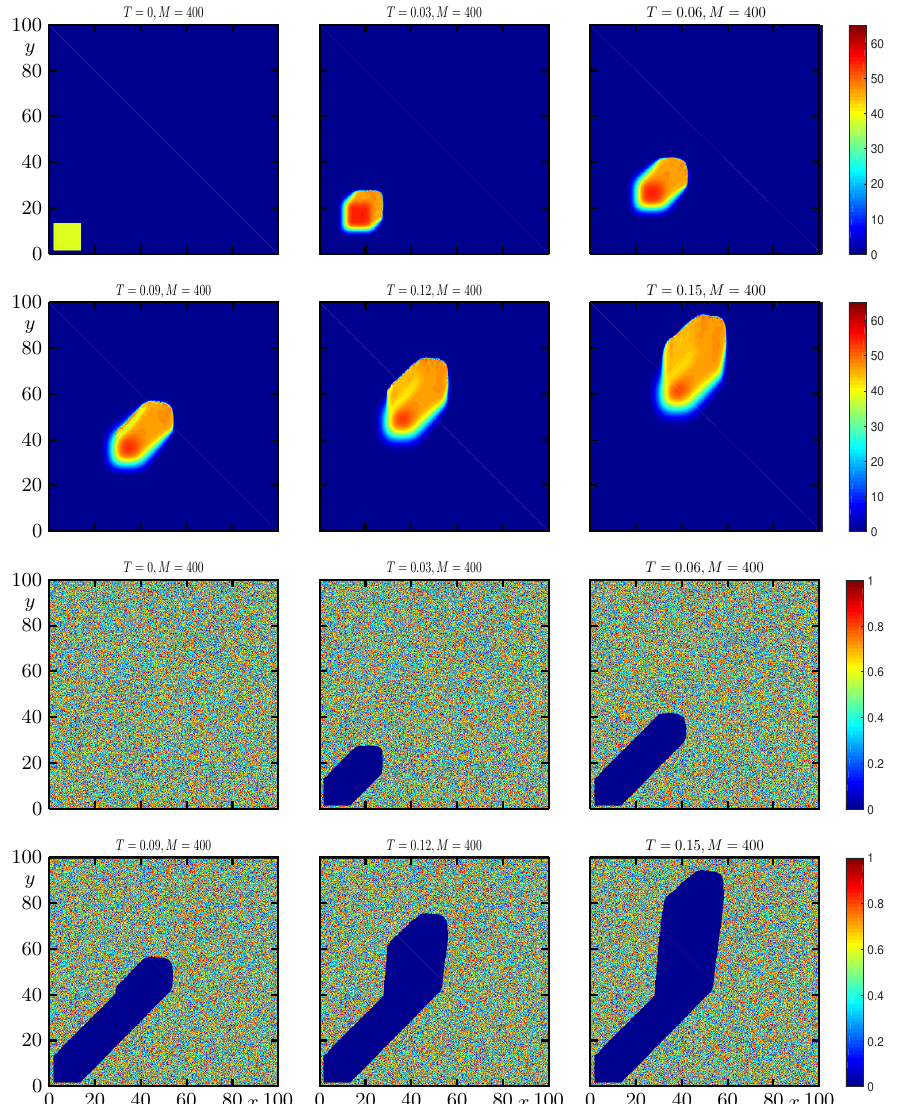
Figure 9. Example 4: Evolution of the dynamics of temperature ( top ) and fuel ( bottom ). Evolution of the non-dimensional temperature and proportion of fuel in space under a change of the wind